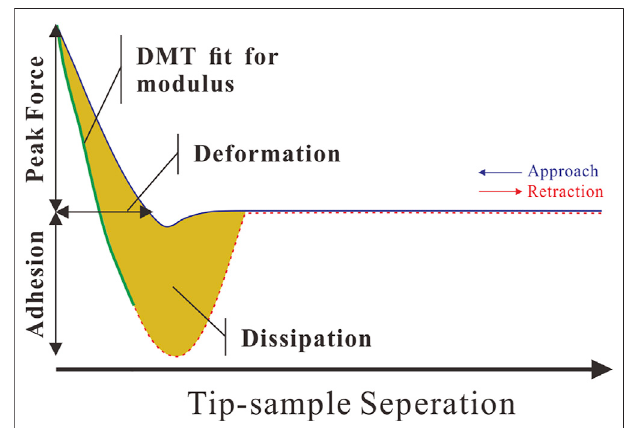
FIGURE 3 | Force curves and information that can be obtained from them (Bruker